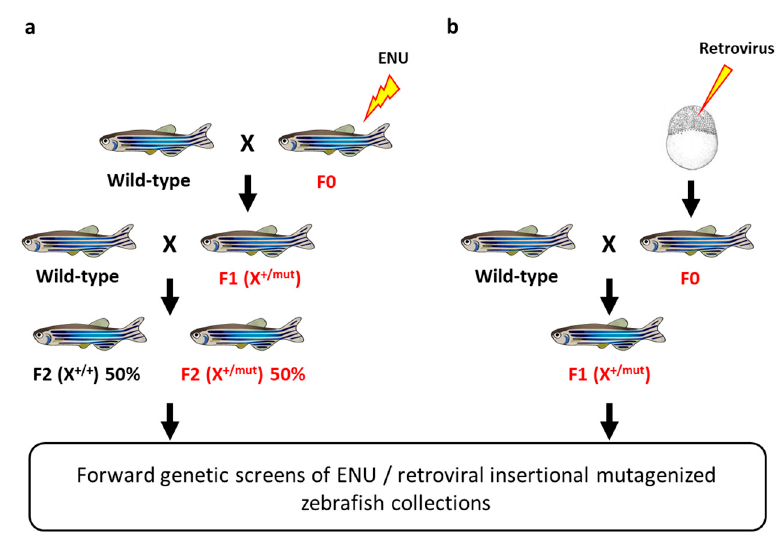
Figure 1. Strategies for forward genetic screens in zebrafish. ( a ) Chemical mutagenesis. Adult male zebrafish are treated with N-ethyl-N-nitrosourea (ENU) mutagen. Mutations induced in the germ cells can be propagated to the next generation through breeding wild-type females. Each F1 offspring contains a unique set of mutations; ( b ) Retroviral insertional mutagenesis. High-titer retroviruses are injected into 1K-stage embryos generating F0 mosaic zebrafish. Germ-line mutations are propagated in F1 through mating with wild-type fish.